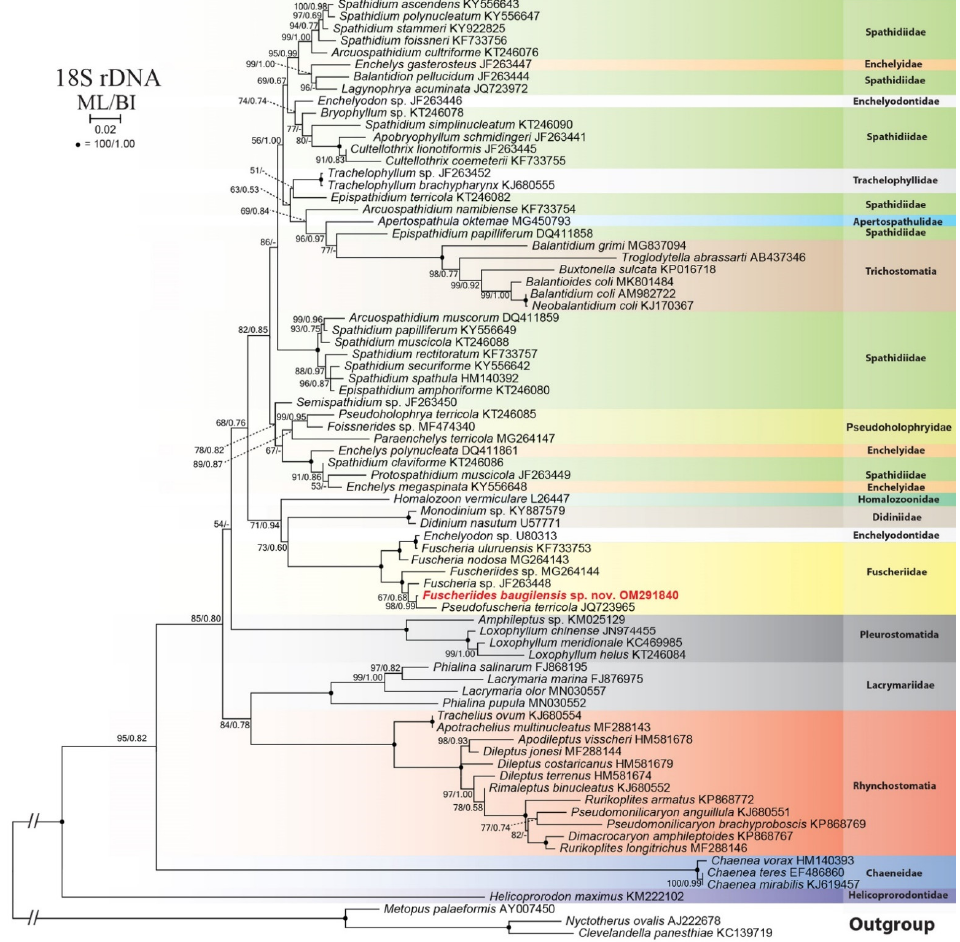
Figure 3. Maximum likelihood (ML) tree based on 18S rRNA gene sequences, showing the phylo- genetic position of Fuscheriides baugilensis sp. nov. Newly obtained sequence is in bold. GenBank accession numbers follow species names. Numbers at the nodes represent the maximum likelihood (ML) bootstrap values and the Bayesian inference (BI) posterior probabilities. Dashes indicate boot- strap values < 50%, posterior probabilities < 0.5, or different topologies in BI and ML phylogenies. The scale bar represents two nucleotide substitutions per 100 nucleotides.